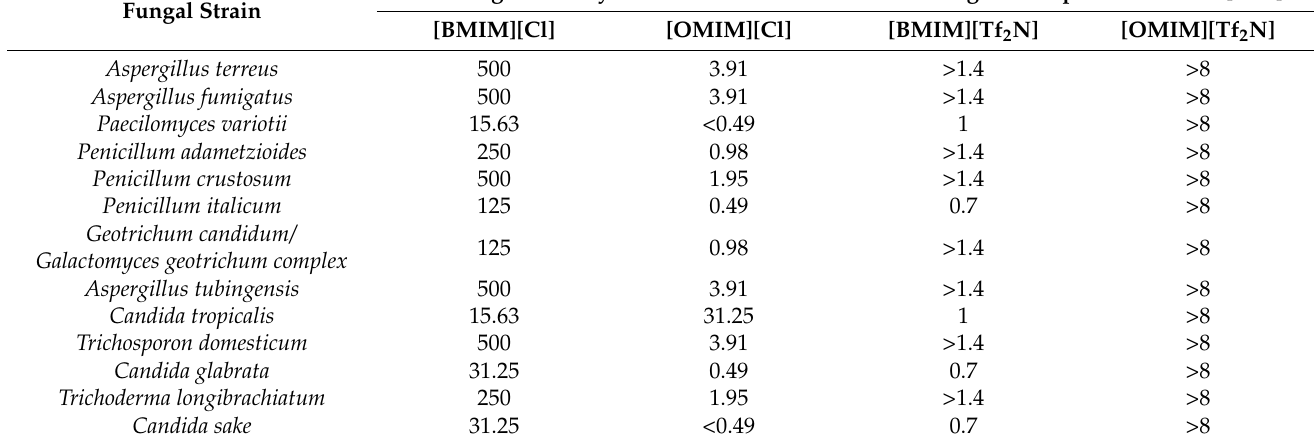
Table 2. Antifungal activity of neoteric solvents investigated against isolated fungal strains presented as